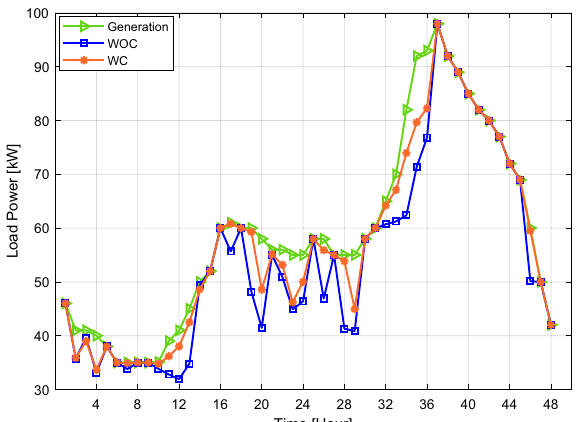
Figure 3. The generated power and energy consumption for coordination and without